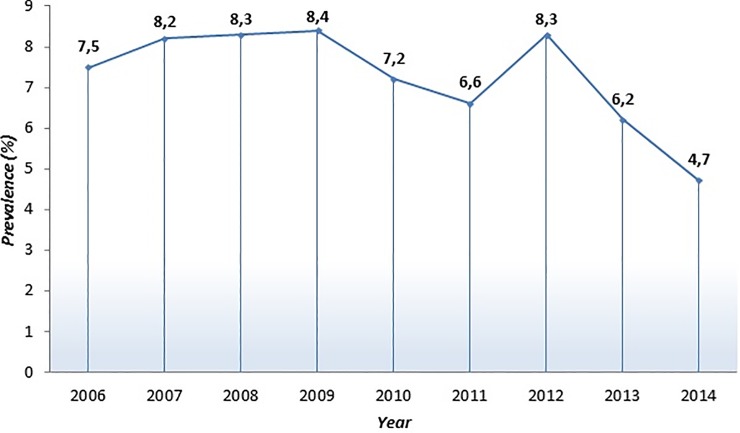
Prevalence of HCV-Ab positive patients from 2006 to 2014.